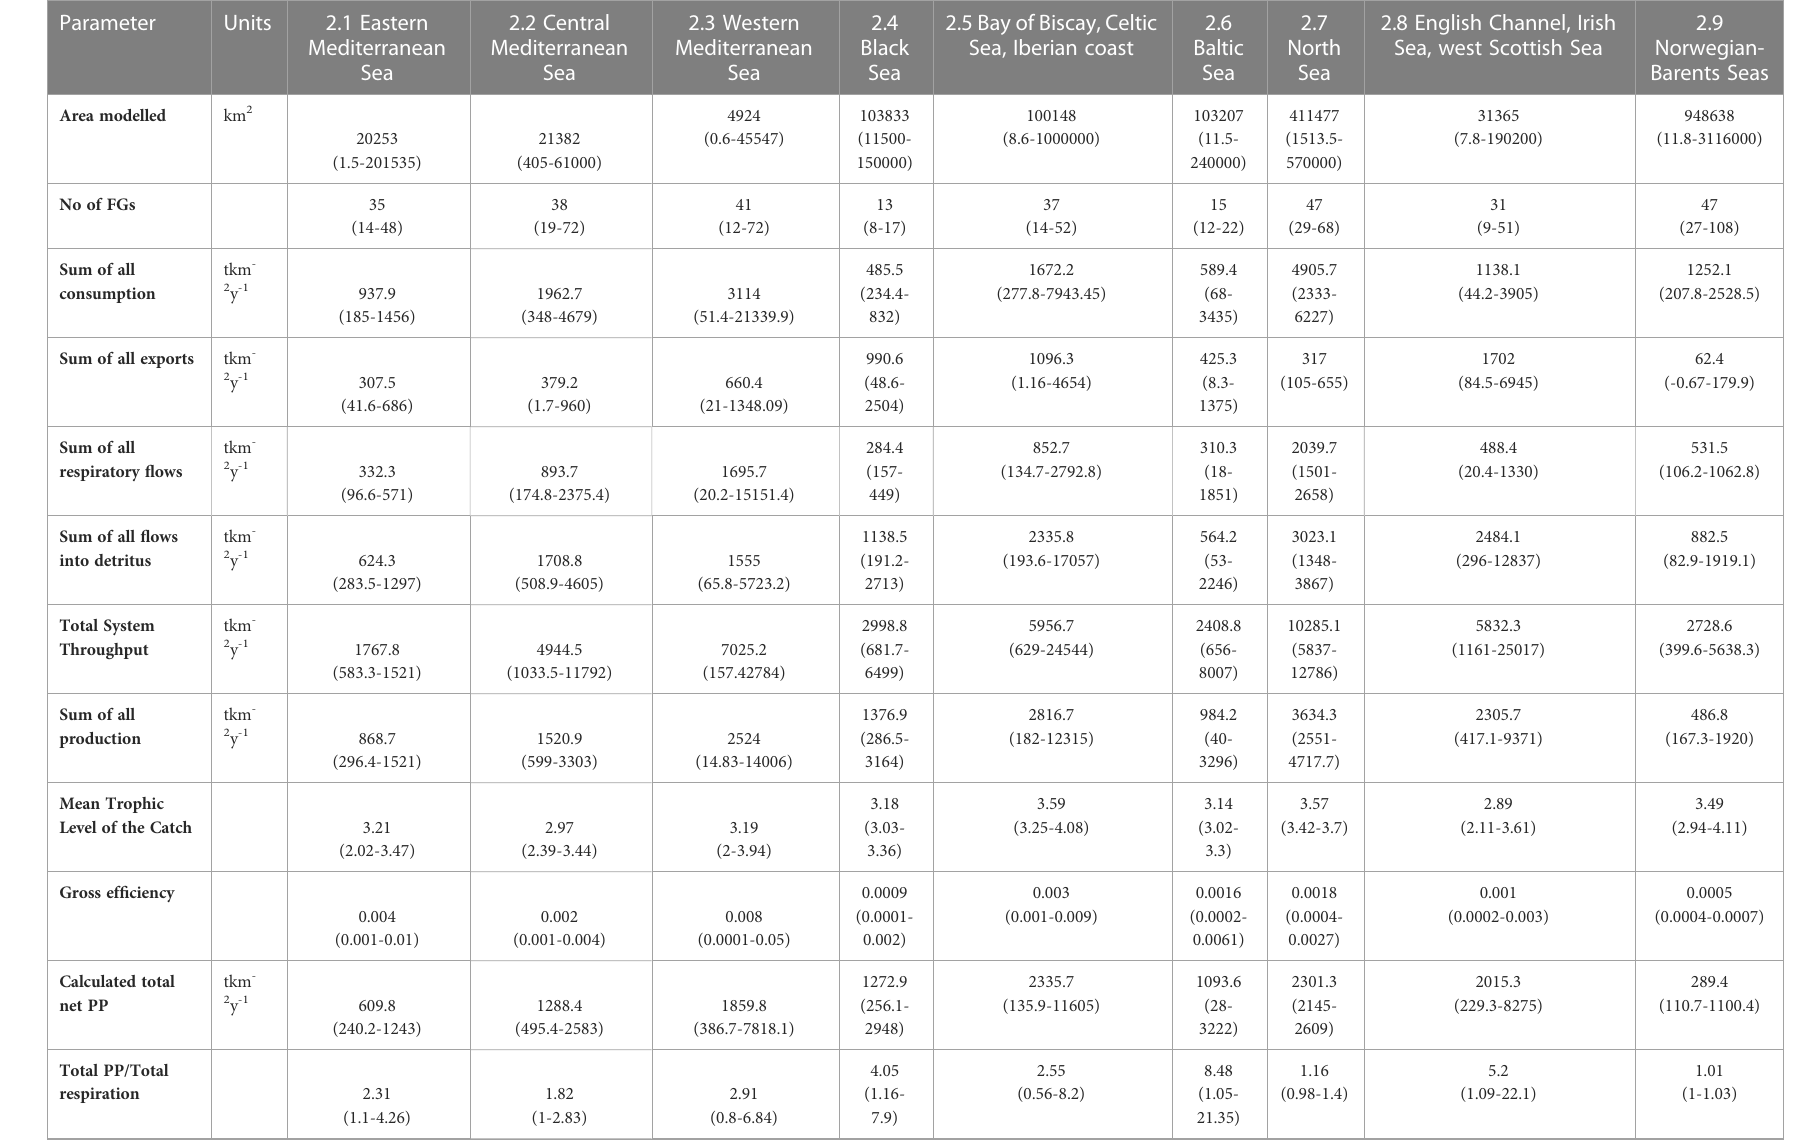
TABLE 2 Summary statistics of Ecopath models in European areas of